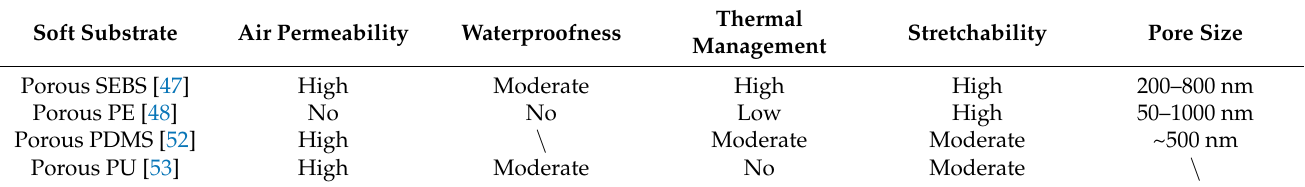
Table 1. Comparisons of the biocompatibility and stretchability of four nanoporous polymer-based flexible